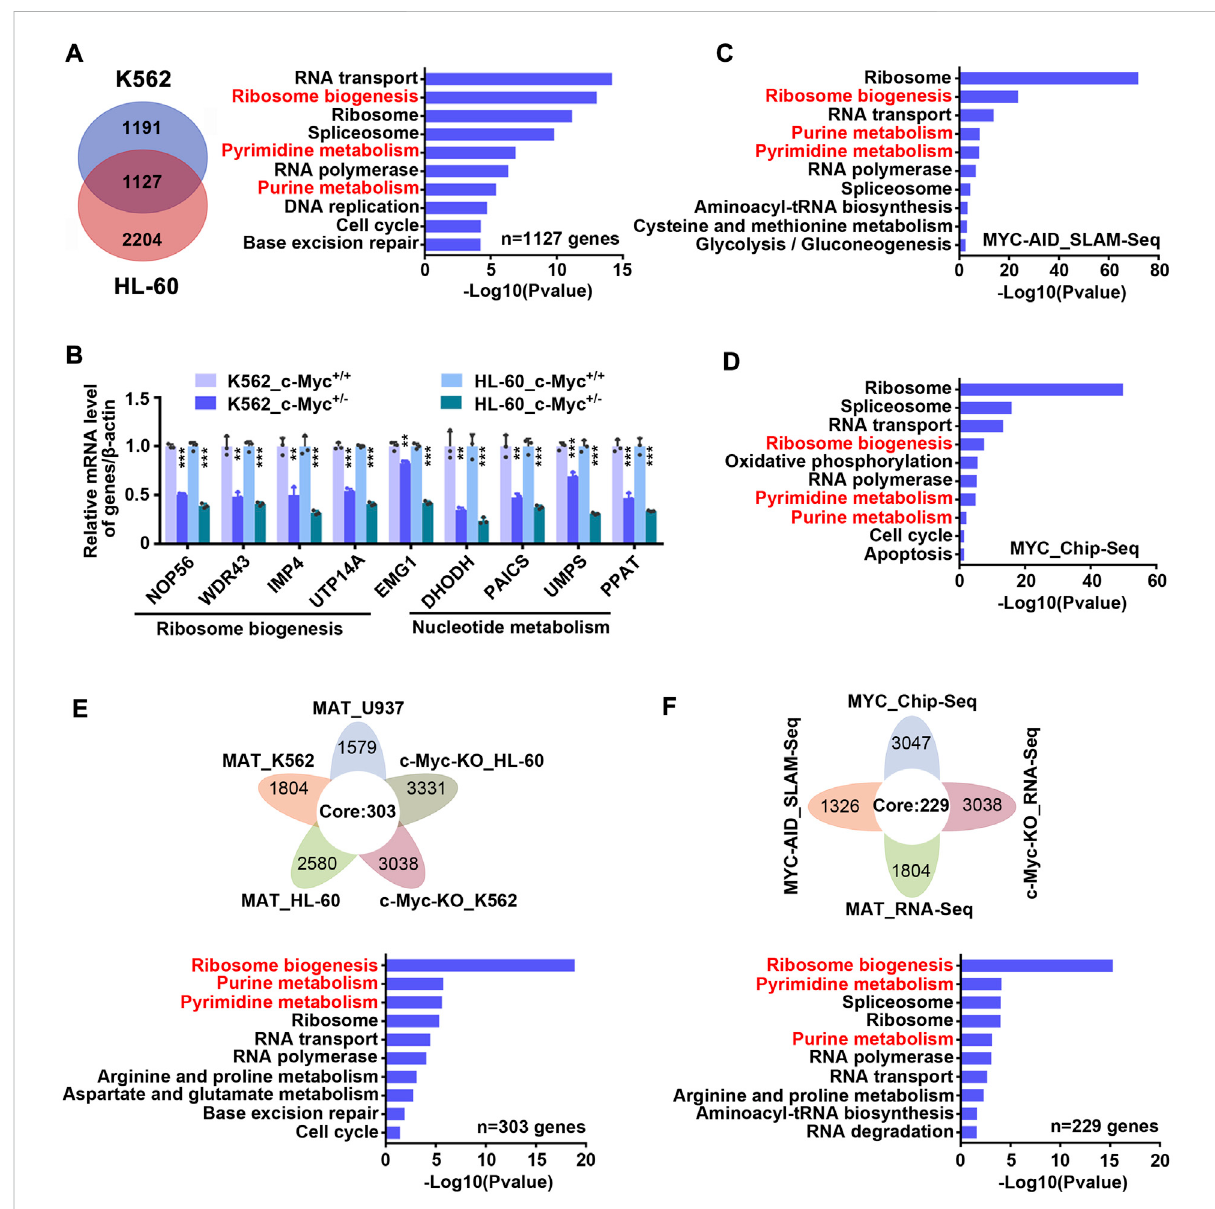
FIGURE 5 Matrine may suppress both ribosome biogenesis and nucleotide metabolism through c-Myc. (A) The intersection and KEGG enrichment analysis of genesdown-regulated(|Foldchange| ≥ 1.2,padj < 0.05)inRNA-SeqofK562andHL-60celllinesuponc-Mycheterozygousknockout.Theintersection(left) and KEGG enrichment analysis (right) are shown. (B) KEGG enrichment analysis for down-regulated genes (|Foldchange| ≥ 1.2, padj < 0.05) upon MYC depletion by AID system (GSE111457). (C) QPCR analysis of representative ribosome biogenesis and nucleotide metabolis-related genes in K562 and HL-60celllinesuponc-Mycknockout. β -actinwasusedasaninternalcontrol.Dataareshownasmean±SEMofthreeindependentlytriplicates.* p < 0.05, ** p < 0.01,*** p < 0.001,unpairedt-test. (D) TheintersectionandKEGGenrichmentanalysisofMYCpotentialtargets(score ≥ 1)fromsevenChip-Seqdatasets (GSM748551,GSM748553,GSM748552,GSM822310,GSM935516,GSM935410,GSM487427,fromCistromedatabase)inK562cellline. (E) Theintersection andKEGGenrichmentanalysisofdown-regulatedgenesfromRNA-SeqofU937,HL-60andK562celllinestreatedwithmatrineanddown-regulatedgenes from RNA-Seq of HL-60 and K562 cell lines upon c-Myc knockout. (F) The intersection and KEGG enrichment analysis of down-regulated genes from MAT_RNA-Seq,c-Myc-KO_RNA-Seq,MYC-AID_SLAM-SeqandMYCpotentialtargetsfromMYC_Chip-seqinK562cellline.Flowerplot(above)andKEGG enrichment analysis (below) are shown (E,F)